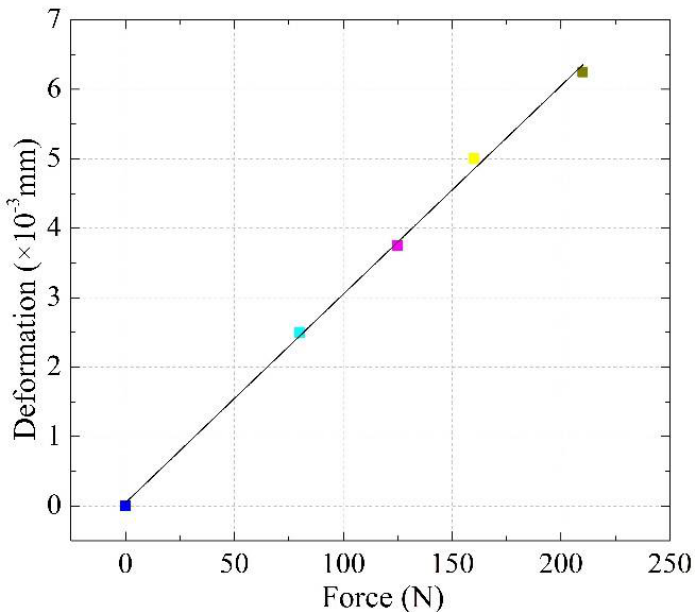
Figure 9. Force-displacement diagram.